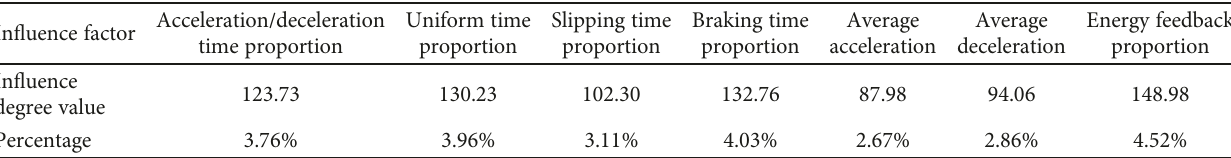
Table 3: The in fl uence degree of energy consumption in fl uence factors (driving characters).